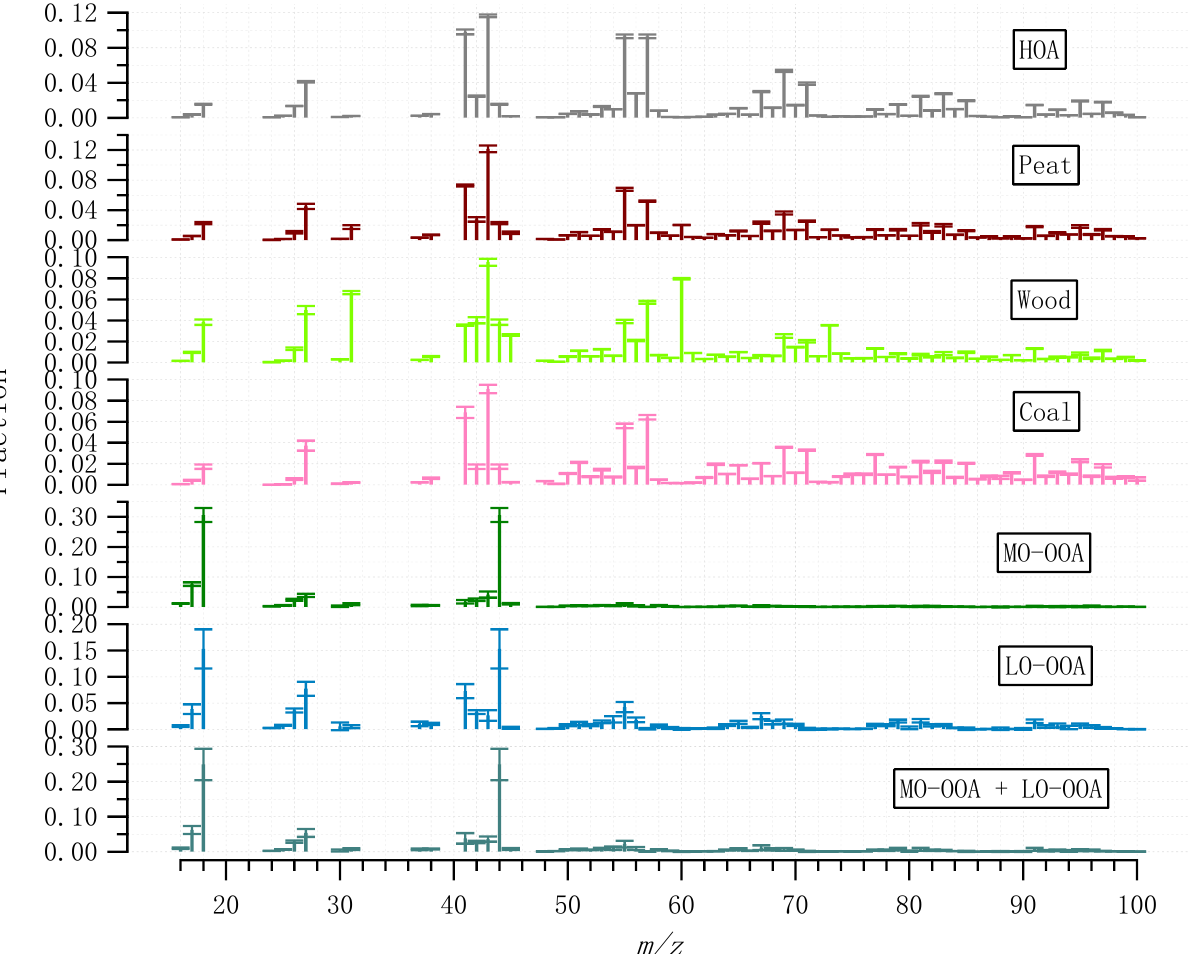
Figure 3. Averaged mass spectral profiles of the OA factors resolved by the rolling PMF strategy. Error bar represents one standard deviation.